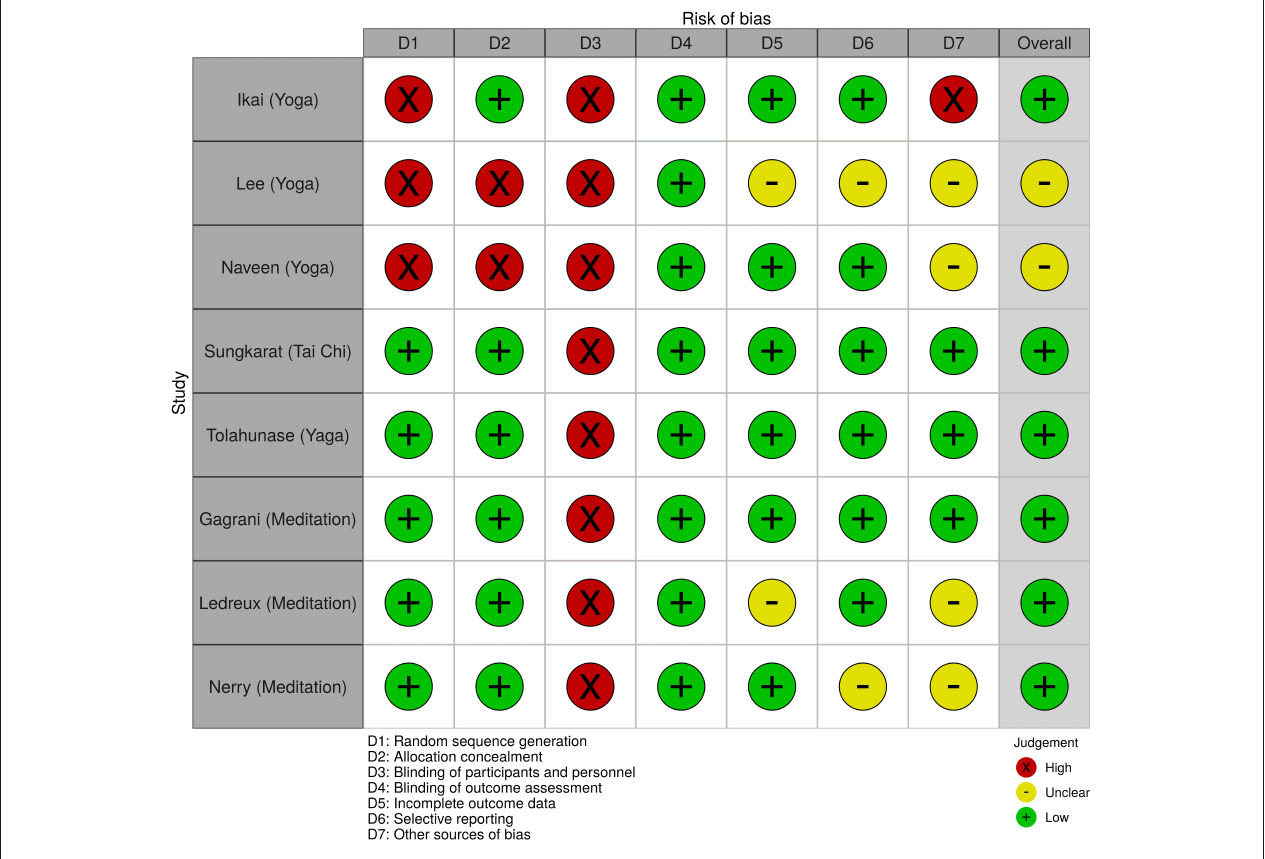
FIGURE 2 | The quality of